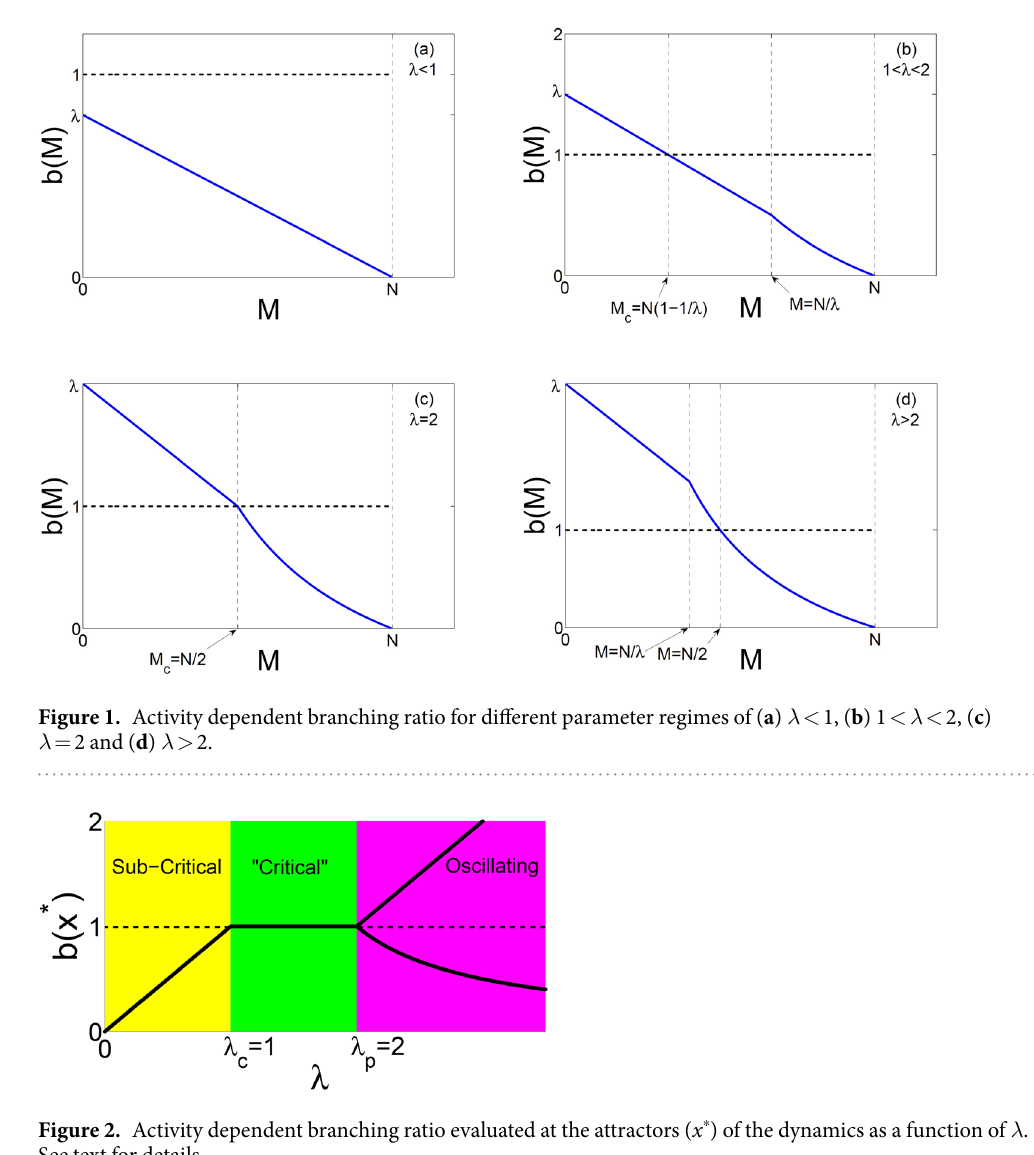
Figure 2 summarizes the mean-field behavior of the system. Three parameter regimes are presented. For 0 < λ < 1 the activity dependent branching ratio at the stable attractor of the dynamics is equal to b ( x * ) = λ < 1 and the system is sub critical. For 1.0 ≤ λ ≤ 2.0 the activity dependent branching ratio is b ( x * ) = 1.0 at the stable attractor of the dynamics and criticality is expected. For λ > 2 we have two values for the branching function and the dynamics jumps back and forth between these two values. λ c = 1 and λ p = 2 are the bifurcation points where the system changes behavior. while the value of λ c is independent of refractory period, the value of λ p ( > 1) depends on the choice of refractory period, see Appendix.